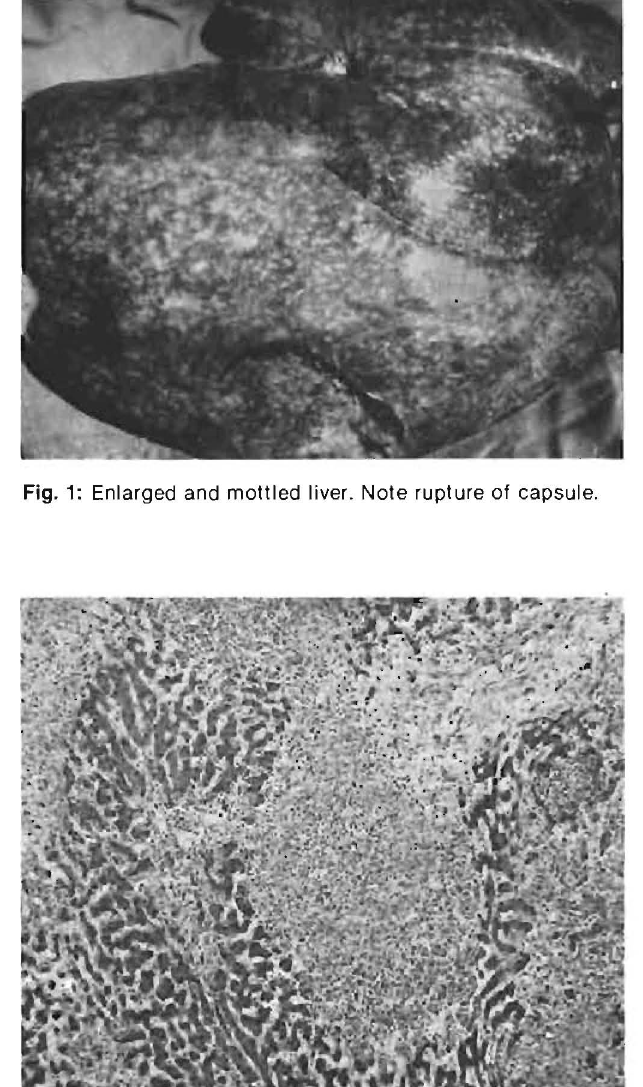
Fig. 2: Randomly distributed foci of hepatic necrosis. HE X 70